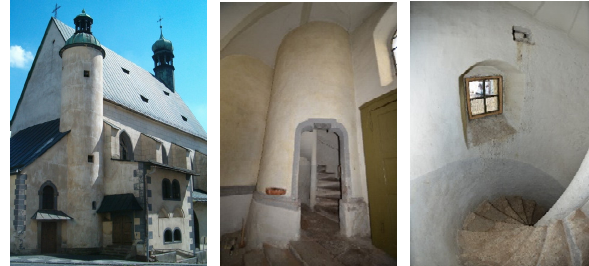
Figure 9. Exterior scene of staircase, entry and interior (from left to right)